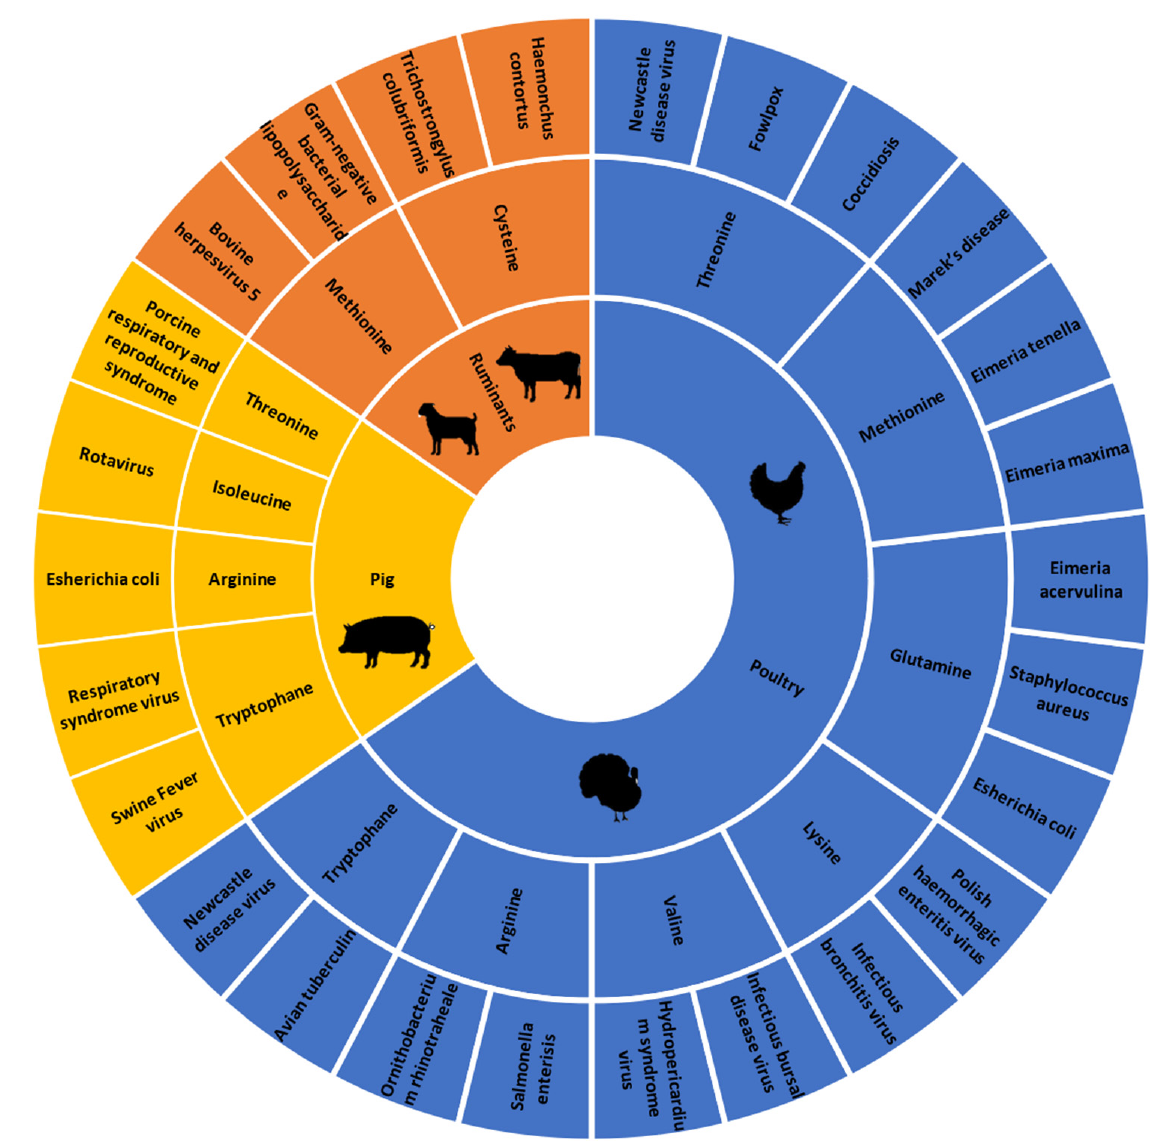
Figure 3. Repartition of livestock, amino acids and immune stressors among the selected articles.